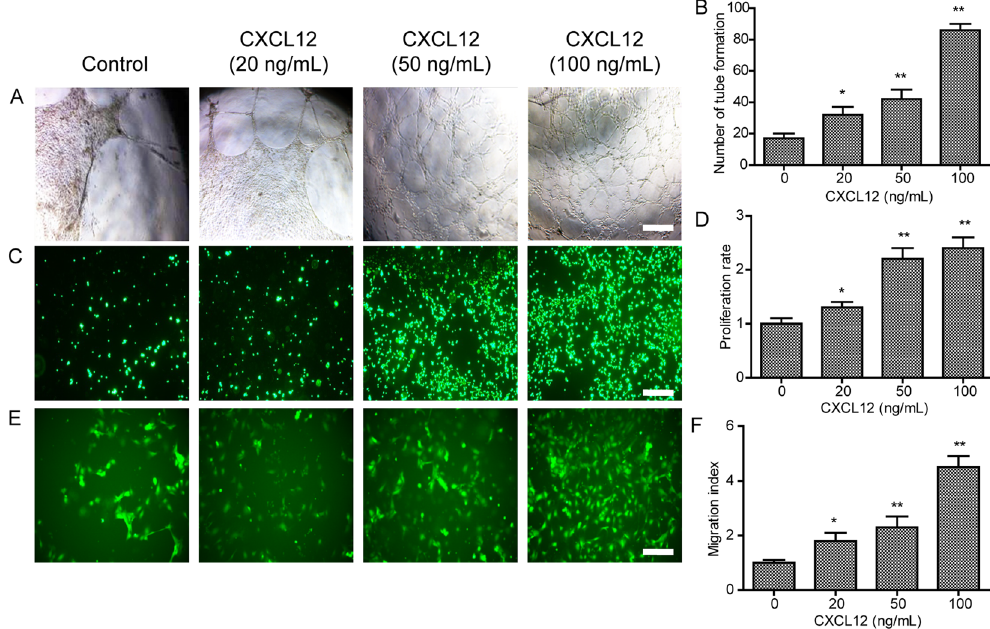
Figure 1. The CXCL12 enhances tube formation, proliferation and migration in HUVECs. ( A ) The tube formation of HUVECs increased with CXCL12 (0, 20, 50 and 100 ng/mL) treatment for 24 h in matrigel. ( B ) Quantitative analysis of the tube formation of HUVECs as shown in A. ( C ) The proliferation of HUVECs increased with CXCL12 (0, 20, 50 and 100 ng/mL) treatment for 72 h in culture. ( D ) Quantitative analysis of the proliferation of HUVECs as shown in C. ( E ) The migration of HUVECs increased with CXCL12 (0, 20, 50 and 100 ng/mL) treatment for 8 h in transwell. ( F ) Quantitative analysis of the migration of HUVECs as shown in E. Values are shown as mean ± SD, n = 3, * p < 0.05/ ** p < 0.01 versus control. Scale bars, 200 μ